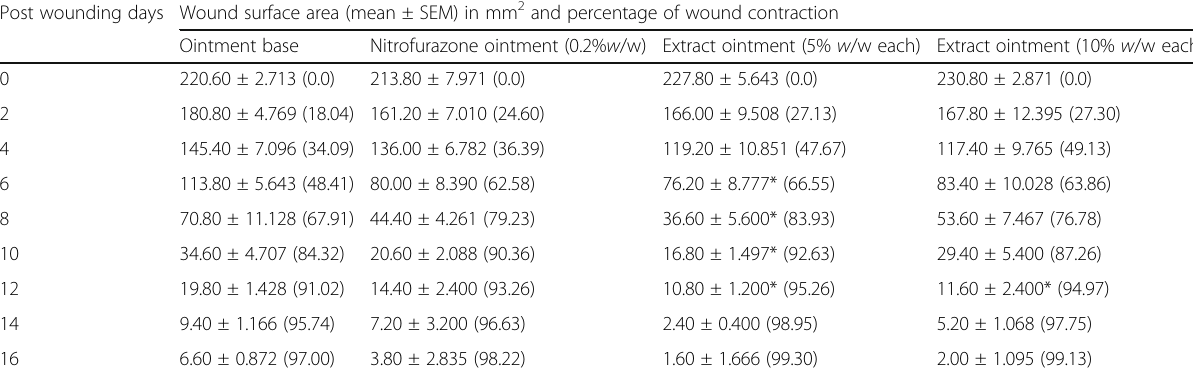
Table 4 Effect of the methanol extract of H.micranthus leaves on excision wound model ( n = 6) Post wounding days Wound surface area (mean ± SEM) in mm 2 and percentage of wound